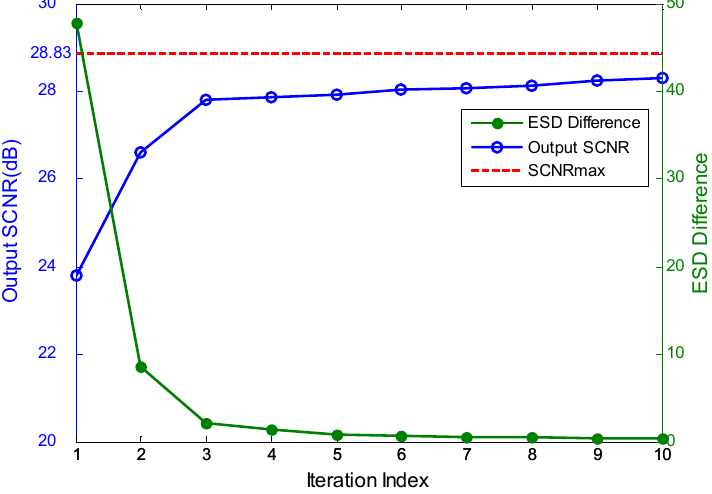
Figure 5. Output SCNR and ESD difference versus number of iterations.